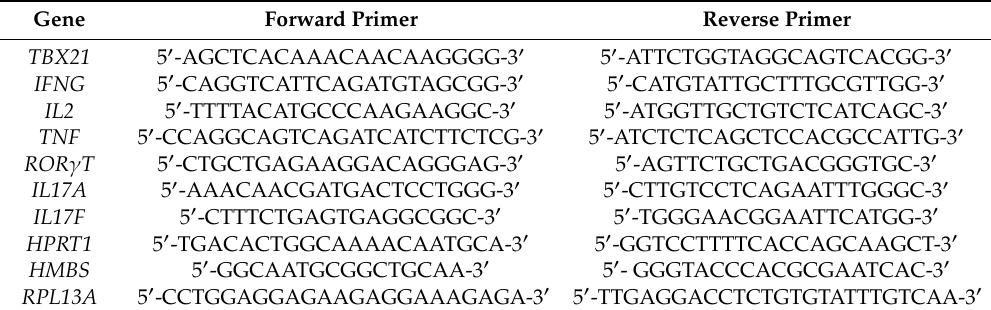
Figure 4. SARS-CoV-2-specific gene expression in fully differentiated Th1 cells. CD4 + cells were differentiated towards Th1 lymphocytes for 5 days, restimulated with anti-CD3 and anti-CD28 beads, and then activated with 1 µ g / mL SARS-CoV-2 proteins S (spike) and N (nucleocapsid) for 24 h. mRNA expression of IFNG ( A ), IL2 ( B ), TNF ( C ), and TBX21 ( D ) genes in Th1 cells. Data show individual values for seven independent donors ( n = 7). “Control” denotes cells cultured in the absence of SARS-CoV-2 proteins for 24 h, and “S-protein” or “N-protein” denotes cells cultured in the presence of SARS-CoV-2 protein (S or N, respectively) for 24 h. Control values are the same for both conditions (S and N proteins). Straight lines connecting two points (control and given protein) identify samples from a specific donor. An asterisk indicates a statistically significant difference at p < 0.05. Statistical analysis was performed using Friedman repeated measures ANOVA on ranks followed by Student–Newman–Keuls post hoc test. Table 1. PCR primers used in quantitative